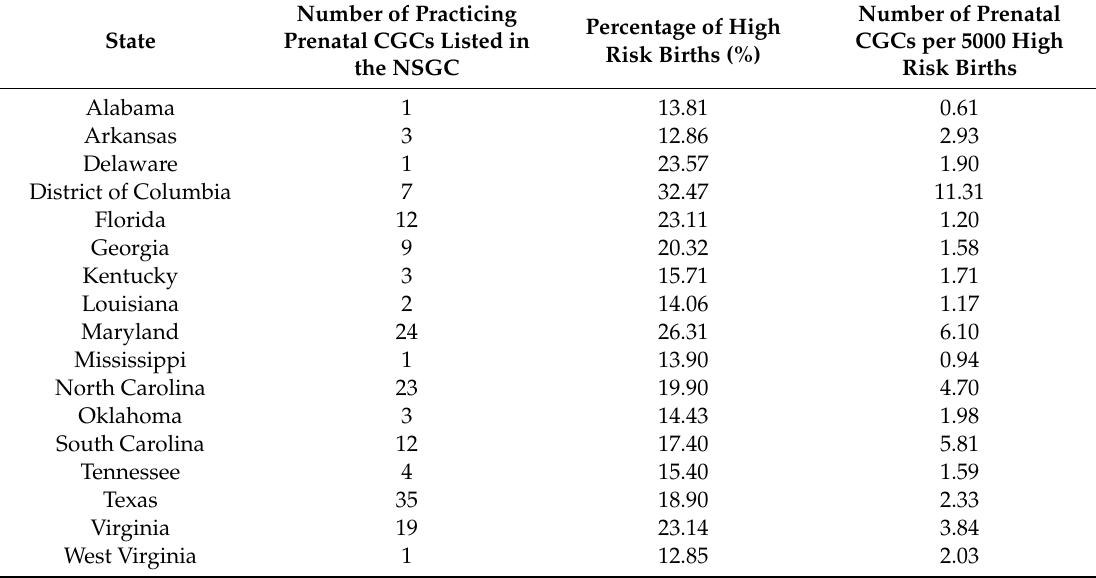
Table 3. The total number of practicing certified genetic counselors (CGCs) that specialize in prenatal genetics and the number of births in the past 12 months (for all ages and for women aged 35–50, categorized as high-risk) for each state of the Southern United States. Note: Given that specializations were only available for data from the National Society of Genetic Counselors (NSGC), the table only reports figures for the counselors that were identified through the